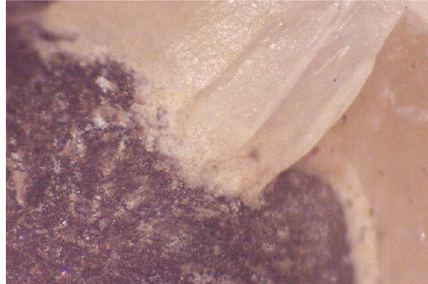
Figure 8: Stereomicroscopic images of the fractured crowns showing combined adhesive-cohesive mode of failure at 35x magnification.